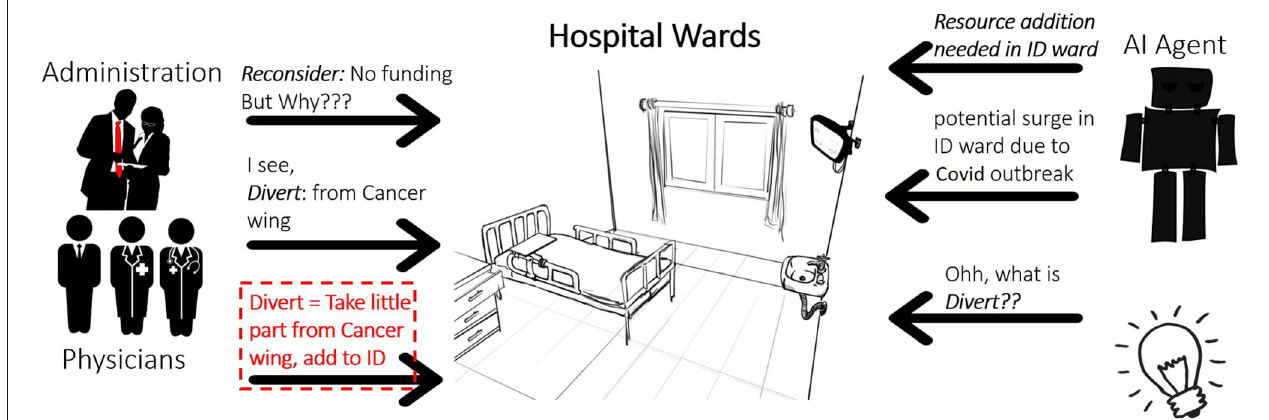
FIGURE 2 | A motivating real-world scenario for concept induction. The concept learnt by the AI agent is “Divert()” .